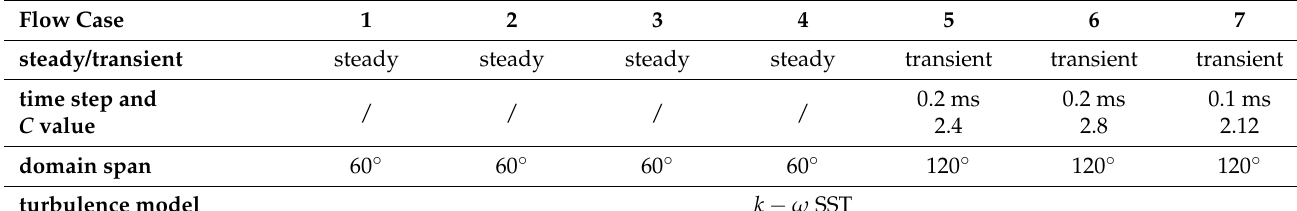
Figure 14. Iso-surfaces with a λ − 2 value of 60 1/s 2 from simulations at the lowest Ta value, viewed from the bottom ( top left ) and top ( top right ), and viscosity ratio values in the air-gap cross section ( bottom ). Table 7. Defined adequate numerical set-ups for the considered flow cases from Lee [6].